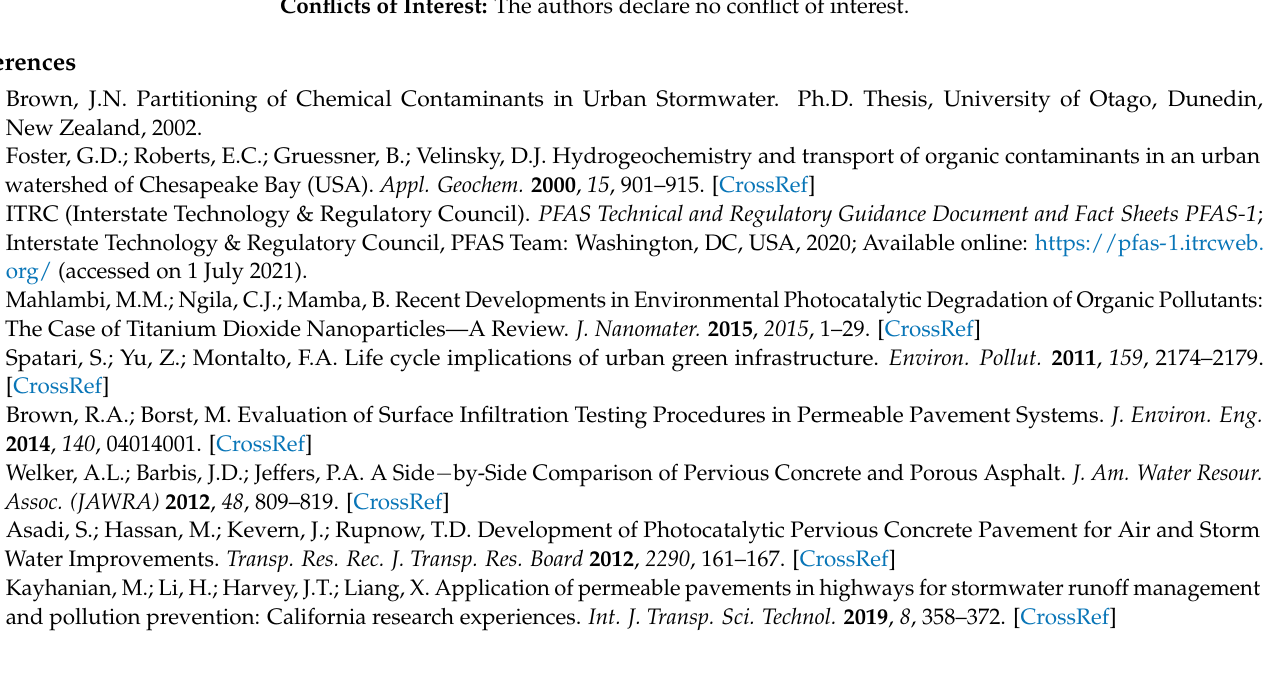
Table S1: Rutile Miller Index; Table S2: Anatase Miller Index, Figure S3: FT-IR Spectrum of TiO 2 , Figure S4: FT-IR Spectrum of Maleic Anhydride, Figure S5: FT-IR Spectrum of Ti-MAH, Figure S6: FT-IR Spectrum of